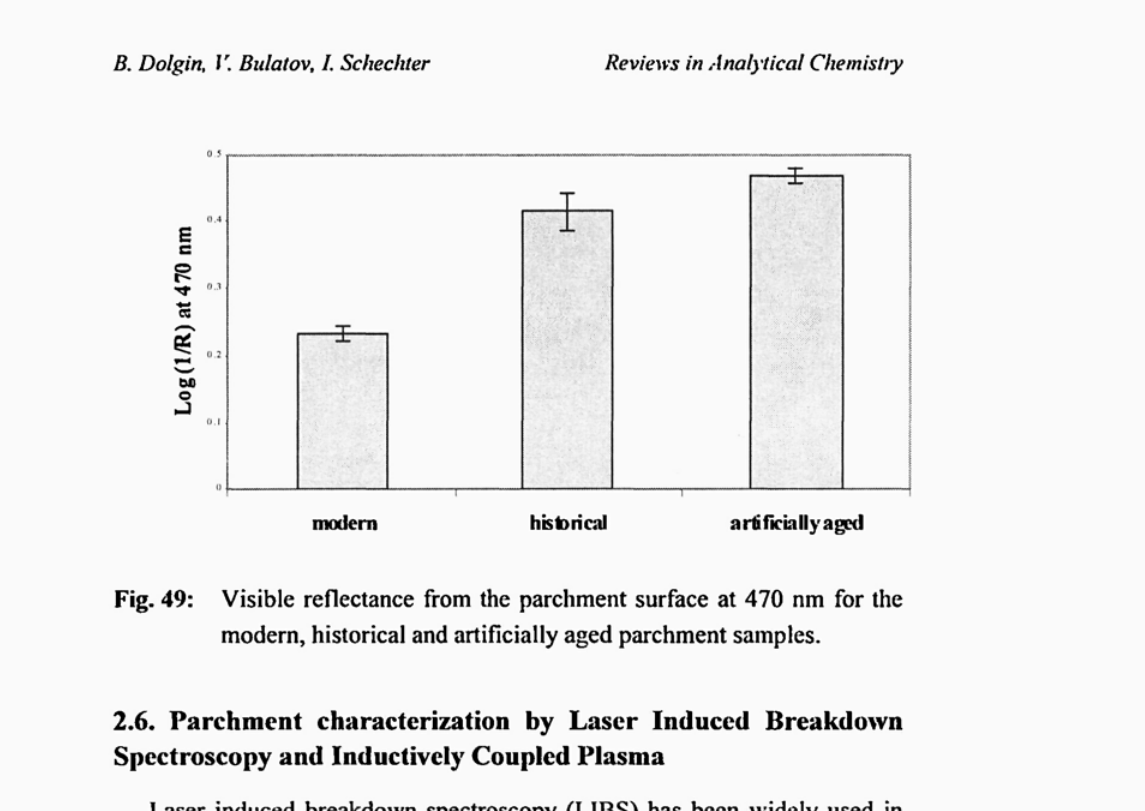
Fig. 49: Visible reflectance from the parchment surface at 470 nm for the modern, historical and artificially aged parchment